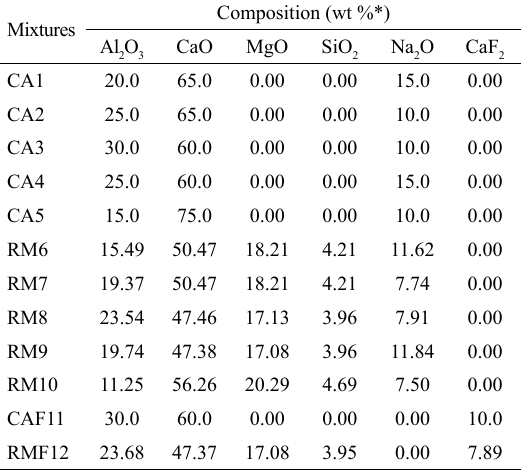
Table 1. Slags compositions used in cast iron desulfurization tests.